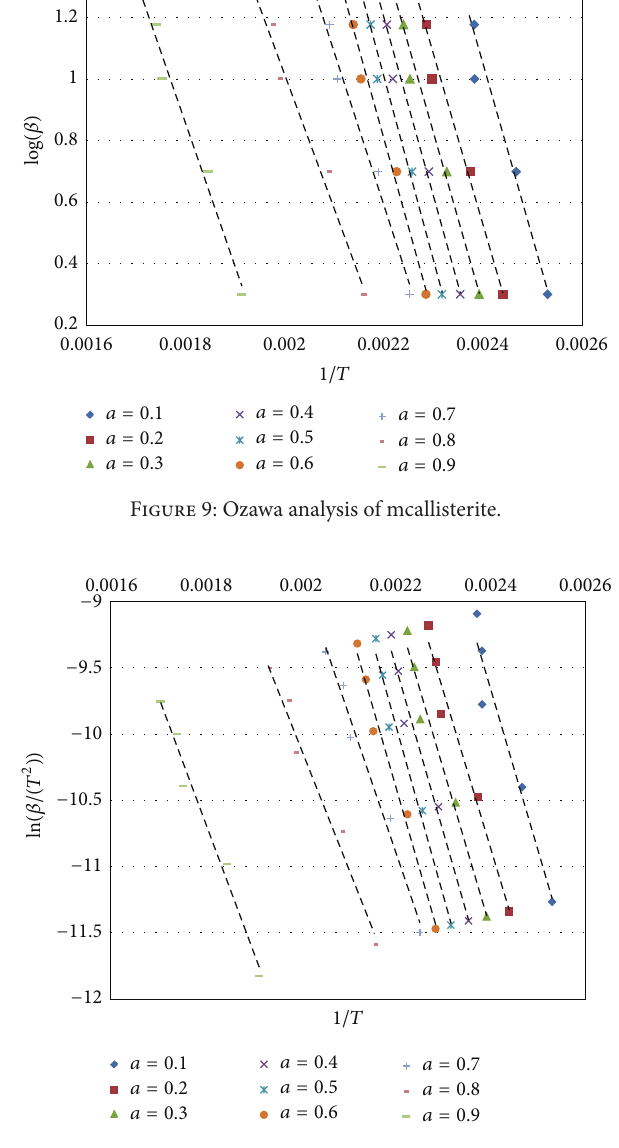
contents (%) of the synthesized magnesium borate